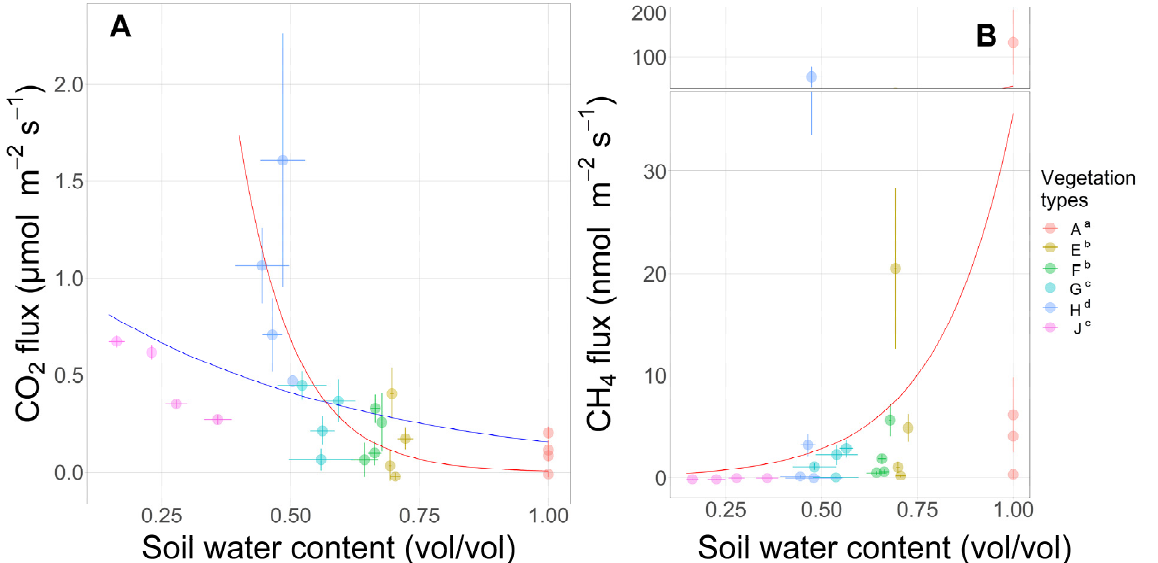
Figure 7. Correlation between soil volumetric water content and soil CO 2 ( A ) and CH 4 fluxes ( B ) along the transect of changing vegetation types from lake surface to the pristine forest at the YYL site (vegetation types A to H) and on a young cypress forest (vegetation type J) 1.5 km away from the site. The measurements obtained between September 2017 and May 2020 were aggregated into four seasons. The 24 data points in each plot represent the average values of CO 2 or CH 4 flux and average soil volumetric water content of the 24 groups of data (i.e., six vegetation types × four seasons). The error bars represent the standard error of mean. The superscript letters in the legend indicate significant differences of soil volumetric water content between vegetation types (Tukey-HSD, p < 0.05). Table 1 presents the vegetation types. Exponential decrease in CO 2 flux with increasing soil volumetric water content is demonstrated by the regression lines with (blue line) and without vegetation type J (red line). The CH 4 flux increases exponentially with soil water content.